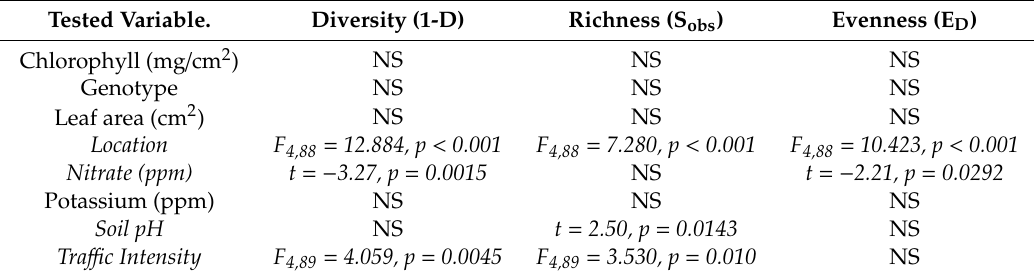
Table 1. The e ff ects of physio-biochemical and geographical parameters (chlorophyll, leaf area, leaf nitrate, potassium, tra ffi c intensity, location and genotype) on fungal community diversity metrics (diversity, richness, evenness) using regression or ANOVA analyses were applicable. NS indicates a non-significant relationship.